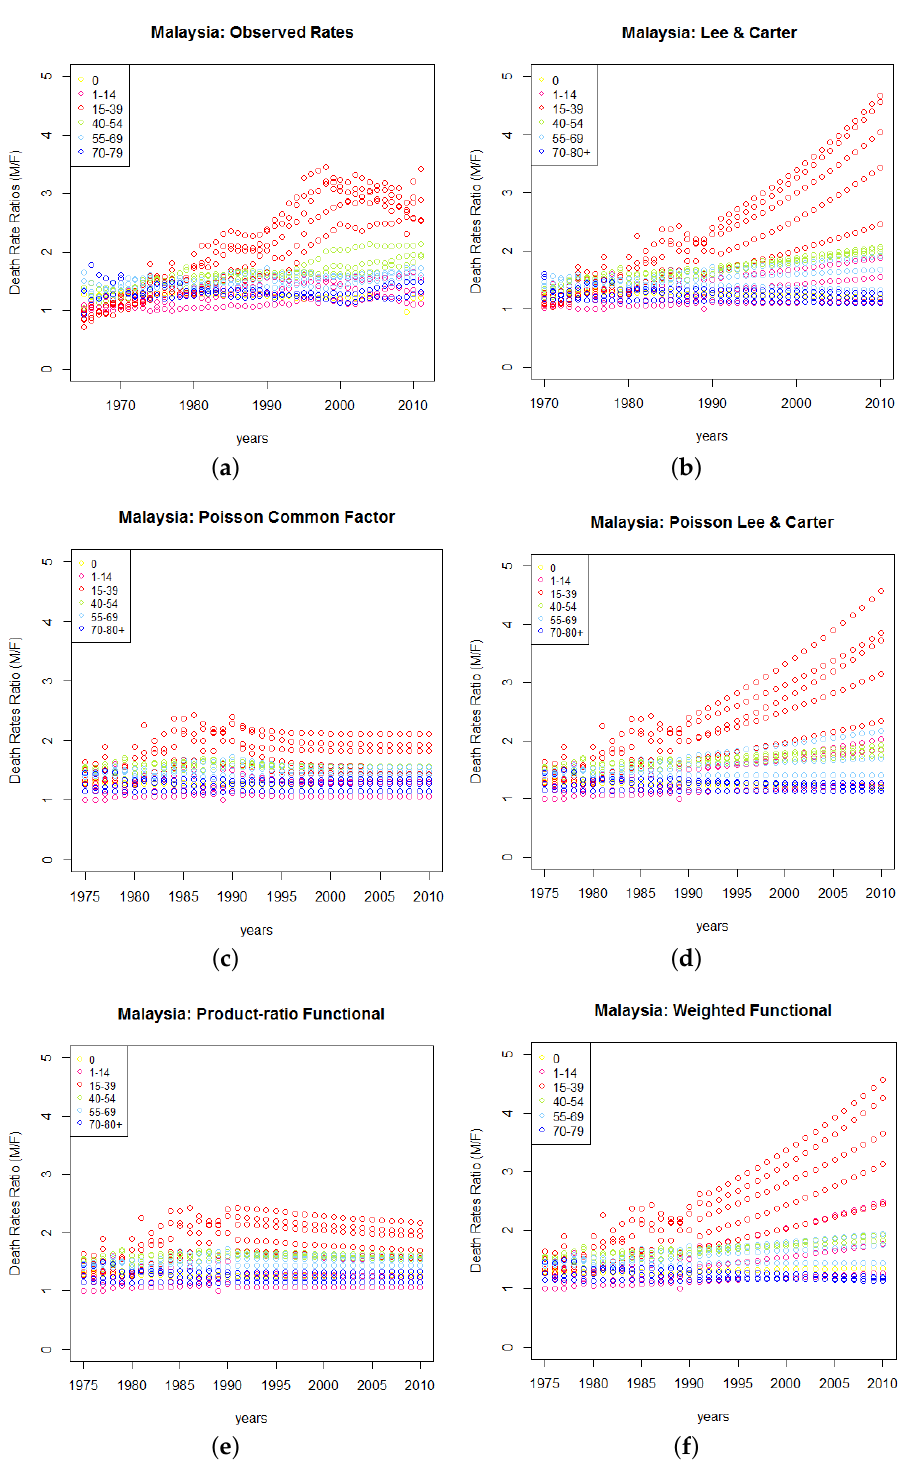
Figure 5. ( a ) Malaysian observed male-to-female death rate ratios 1965–2011, followed by forecasts of these ratios from 1990–2010 using ( b ) Lee-Carter, ( c ) Poisson common factor, ( d ) Poisson-Lee-Carter, ( e ) Product-ratio functional and ( f ) Weighted functional